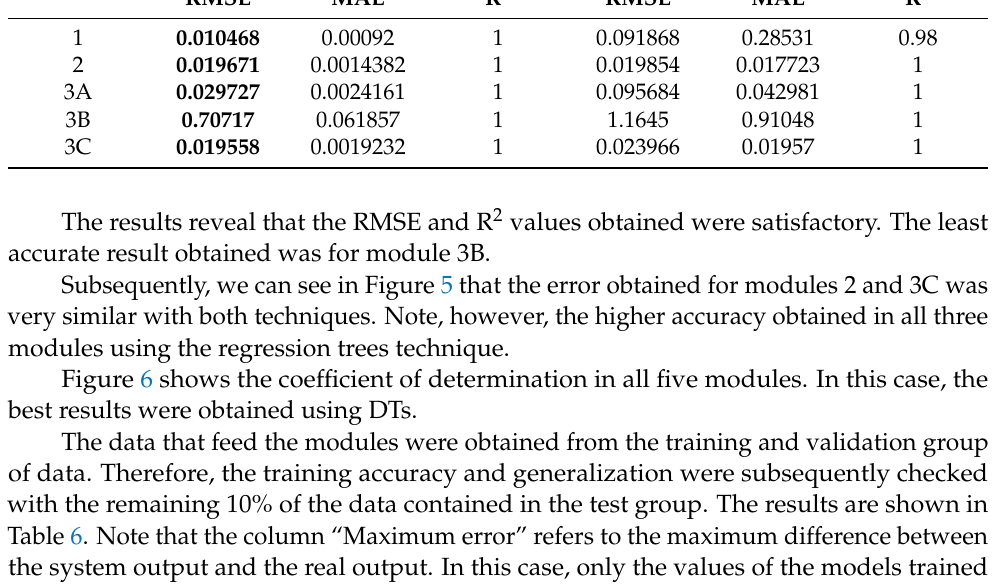
Table 5. Comparison of results after the application of ML techniques. Regression Module